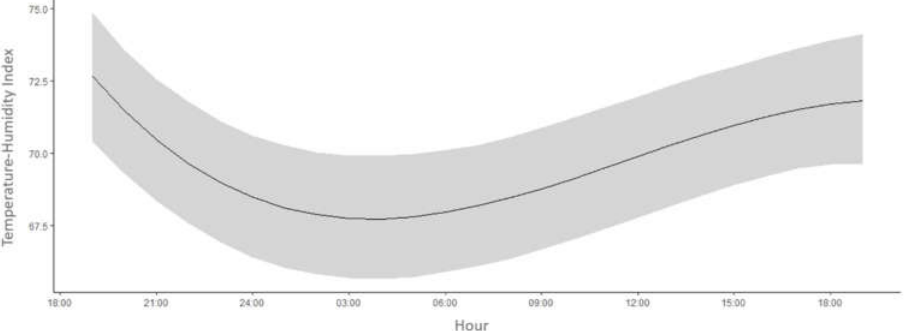
Figure 7. Mean values of Temperature-Humidity Index (THI; 95% Bayesian credibility interval) throughout a 24 h period inside the compost barn.